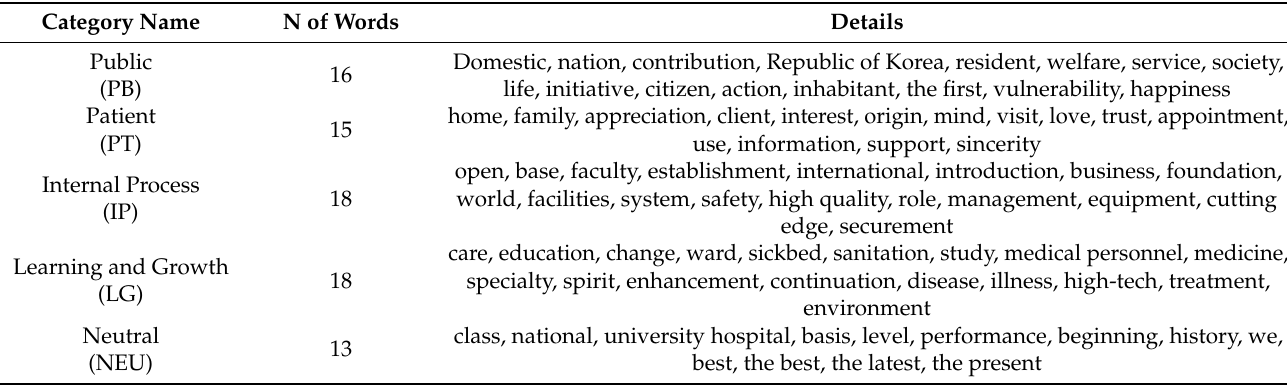
Table 1. The words categorized to balance